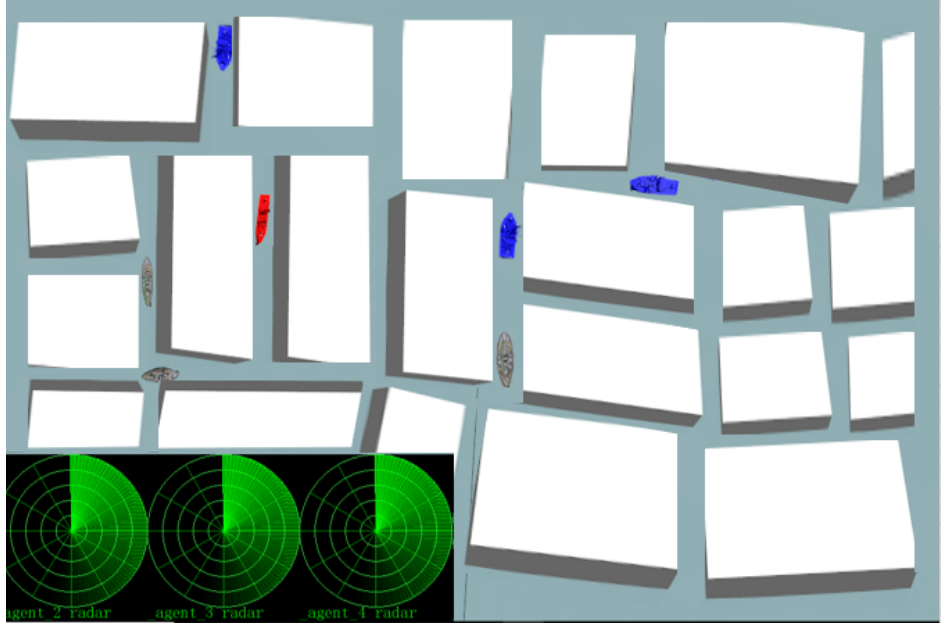
Figure 4. Simulation environment